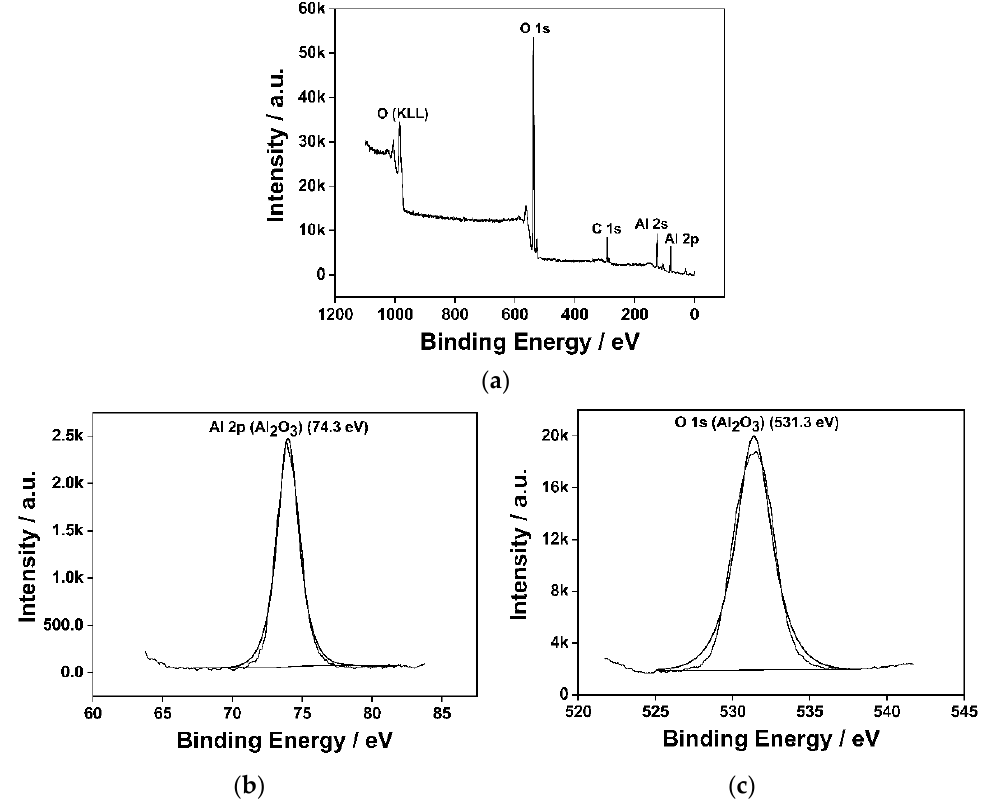
Figure 3. XPS spectrograms of the aluminum surface after reaction with 400 °C of water vapor: ( a ) survey spectrum of the sample surface elements; ( b ) the high-resolution single peak of Al 2p; ( c ) the high-resolution single peak of O 1s.